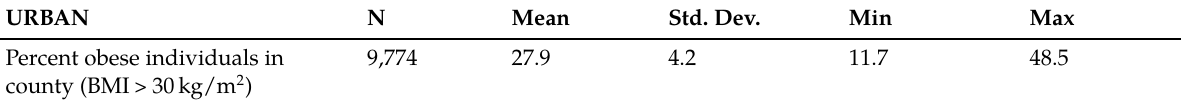
Table 1: Descriptive statistics for rural and urban counties, 2004 – 2012. URBAN N Mean Std. Dev. Min Max Percent obese individuals in county (BMI > 30 kg/m 2 )